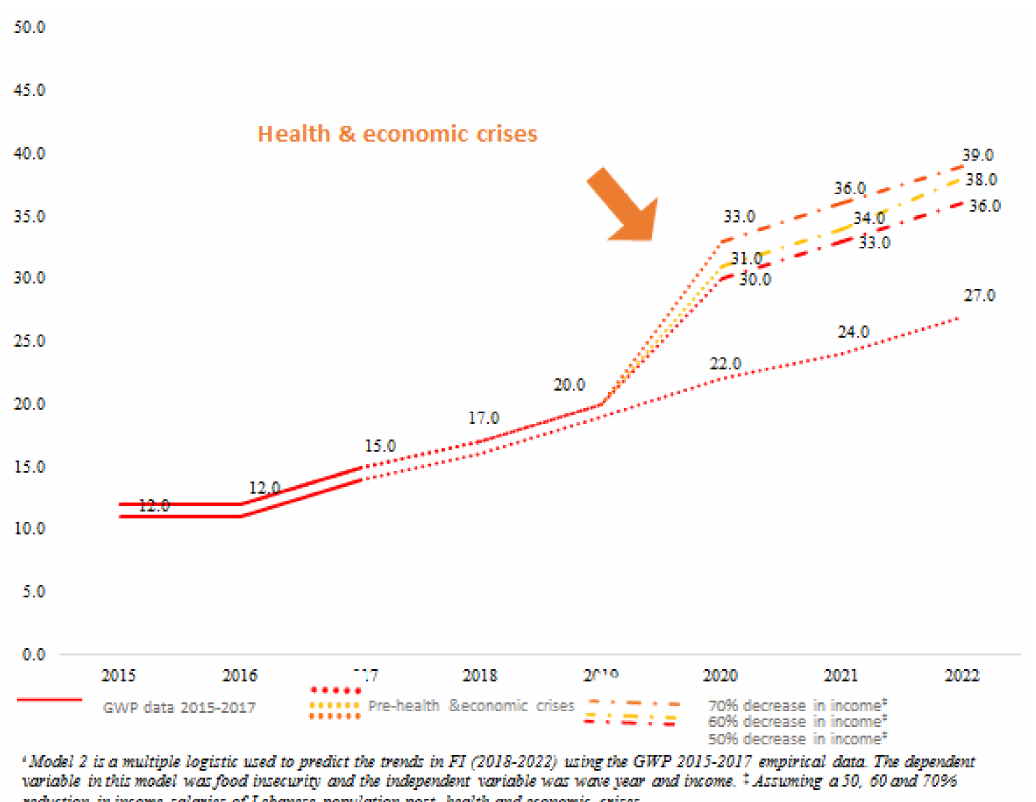
Figure 2. Projections of FI (FI) prevalence among Lebanese adult population using model 2 Figure 1. Trends and projections of FI (2018–2022) among Lebanese adult population using model 1 ŧ (including wave year) from GWP data (2015–2017) ‡